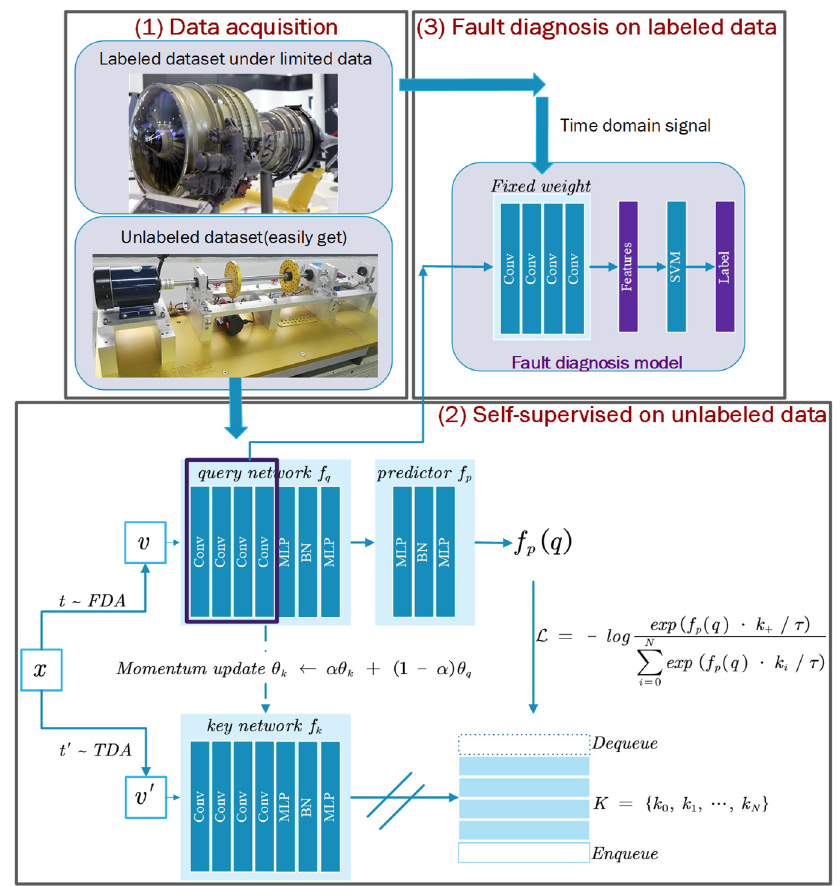
Figure 2. The framework of fault diagnosis based on